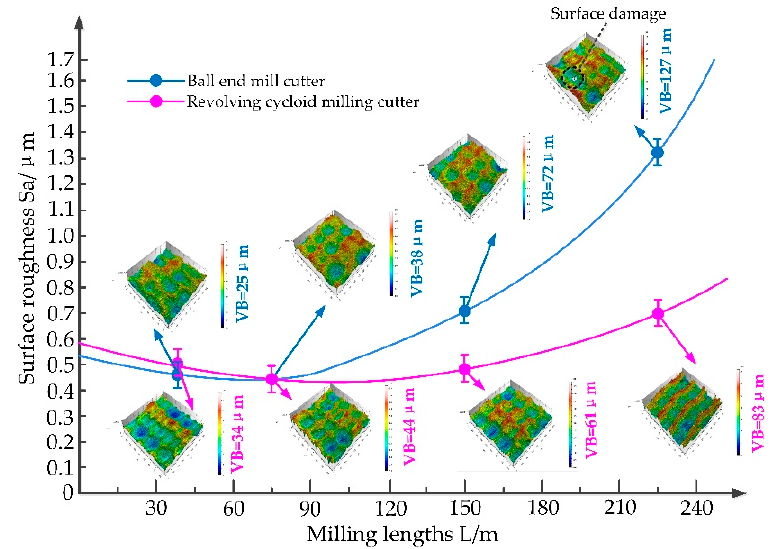
Figure 15. Variation of the 3D surface roughness with milling length.